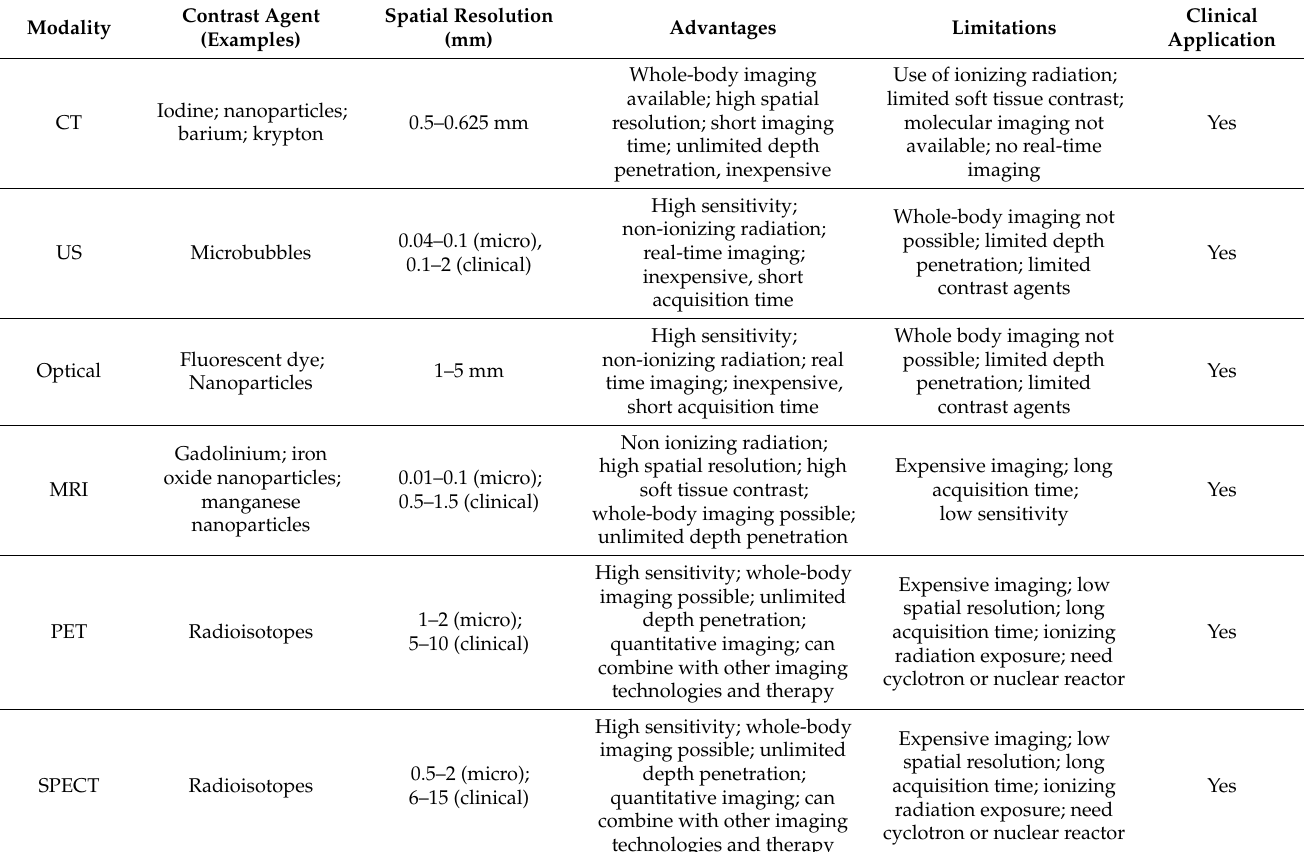
Table 1. Utilization, advantages, and limitations of imaging